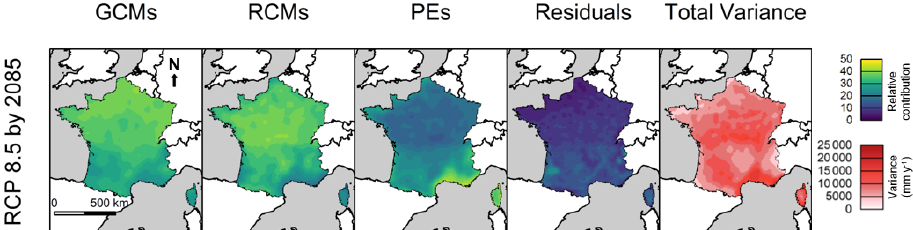
Figure 6. Uncertainty contribution of each impact modeling chain step to changes in PE across France for a 30-year period centered around 2085 for RCP8.5. The contribution to the total uncertainty is presented in percent and is calculated with the QUALYPSO method.